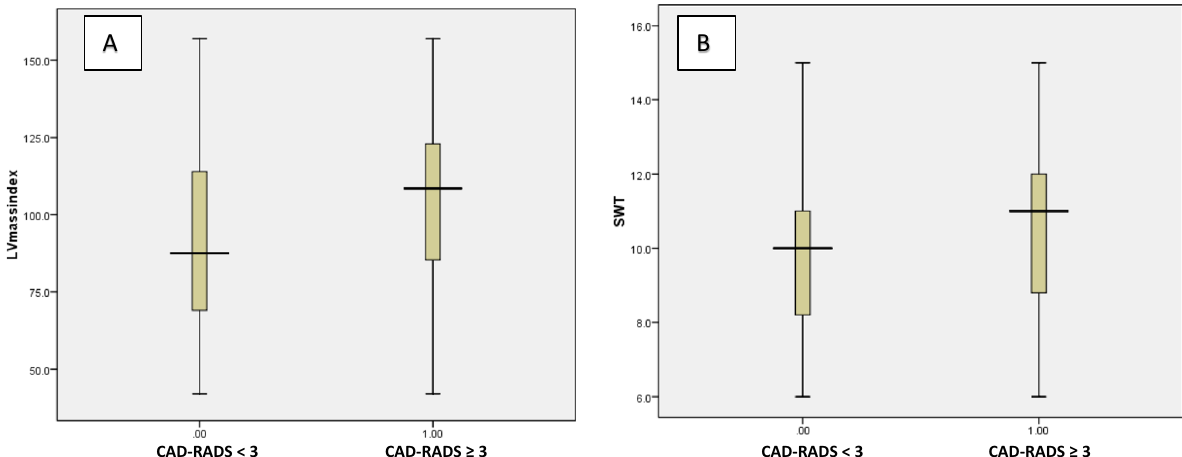
Fig. 3 Comparison between patients with CAD-RADS < 3 vs. those with CAD-RADS (panel B )